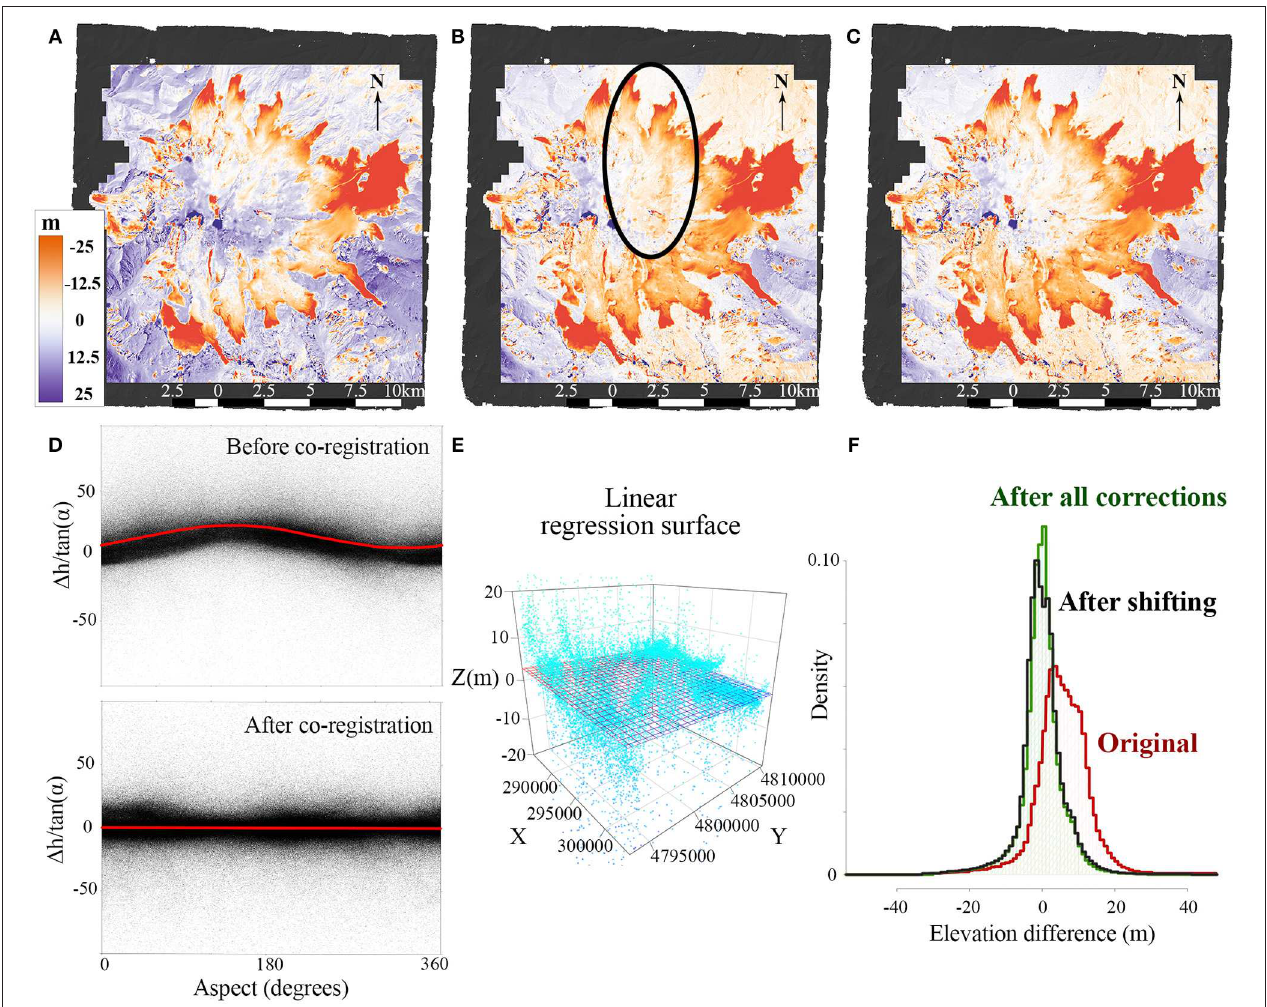
FIGURE 3 | Initial elevation difference ( 1 h) map between 2017 Pléiades and 1997 DEMs (A) before and (B) after co-registration. (C) Final elevation difference raster after along-cross amendment and manual correction. (D) Plots show the aspect-dependent distribution of shift direction and its magnitude on stable terrain before and after co-registration. (E) Regression surface for along- and cross-line correction of the 1997 DEM. (F) The 1 h values distribution improvement through the steps of corrections.